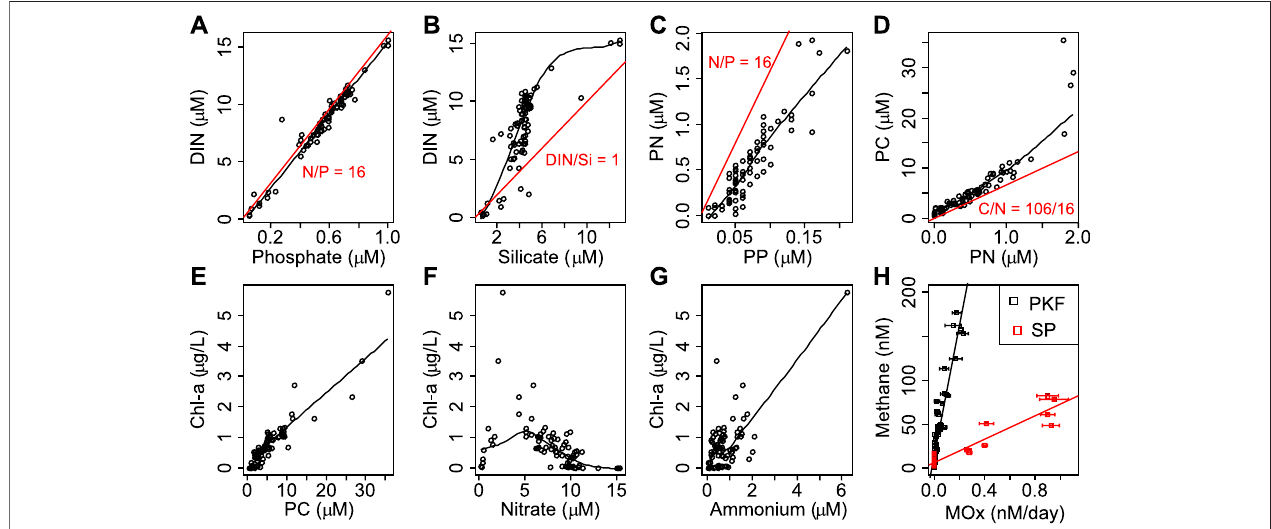
FIGURE4 | Individual relationships betweenbiogeochemical parameters.The black lines show local polynomial regressions between the variables. Red fi eld ratios are provided in red at the top panel. The relationship between methane and methane oxidation rates (MOx) and corresponding linear regression lines are provided in black and red corresponding to Prins Karl Forland (PKF) and Storfjordrenna Pingos (SP). Error bars represent standard deviation of MOx measurements. Abbreviations are PC, PN, PP, particulate carbon, nitrogen and phosphorus; DIN, dissolved inorganic nitrogen; Chl-a, Chlorophyll a.